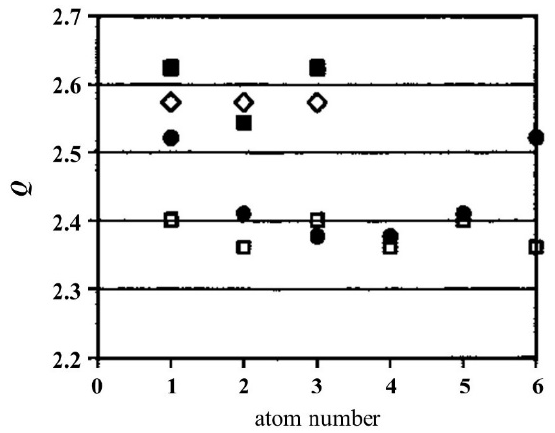
Figure 7. Cluster-size dependence of Q ( n ) / Q ( 1 ) for the 2 MeV/atom C n + emerging from a carbon foil of 2.2 μ g/cm 2 thickness [14]. Linear chain structure ( 〇 ) and ring structure ( ◇ , □ ). Solid symbols with error bar indicate the experimental data [13].